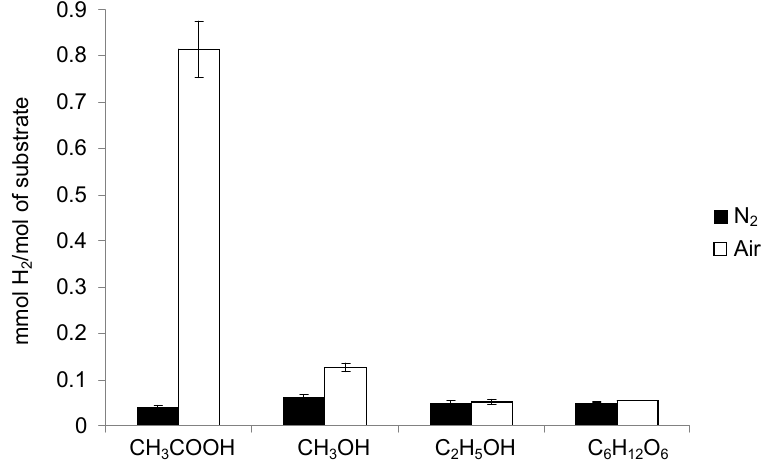
Figure 6. Comparison of the amounts of H 2 evolved during the photocatalytic degradation of various organic substrates after 27 h of irradiation in the presence of Fe/TiO 2